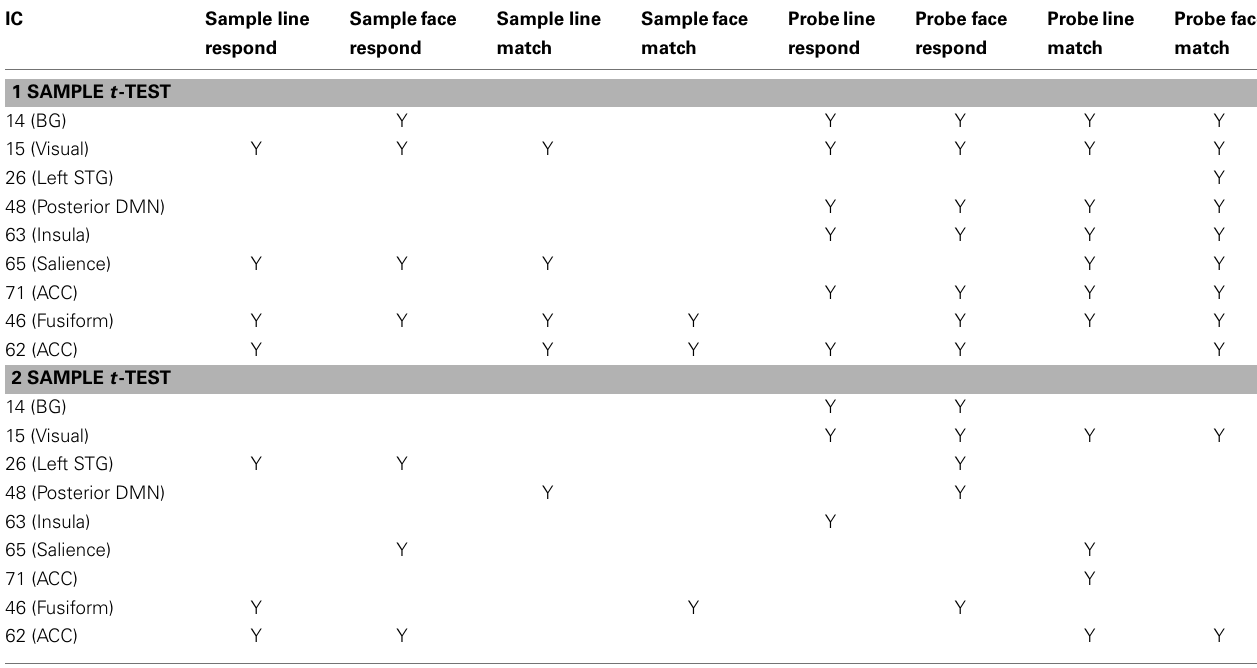
Table 2 | Linear regression between event-related task timecourses and IC timecourses.